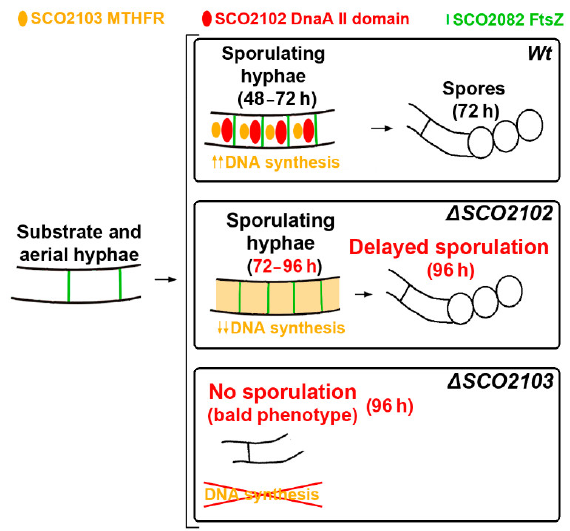
Figure 10. Model outlining the dynamics of FtsZ (green), SCO2102 (red) and SCO2103 (orange) in sporulating hyphae. SCO2102 and FtsZ co-localise in the wild-type sporulating hyphae. SCO2102 is essential for positioning SCO2103 at sporulating hyphae, increasing MTHFR activity and nucleotide synthesis (dTMP), enhancing chromosomal DNA replication accompanying sporulation. SCO2103 is not positioned at sporulating hyphae in the ∆ SCO2102 mutant, reducing dTMP accessibility and delaying sporulation. The absence of SCO2103 MTHFR activity in the ∆ SCO2103 mutant would block the DNA synthesis enhanced by SCO2103, generating a non-sporulating phenotype.